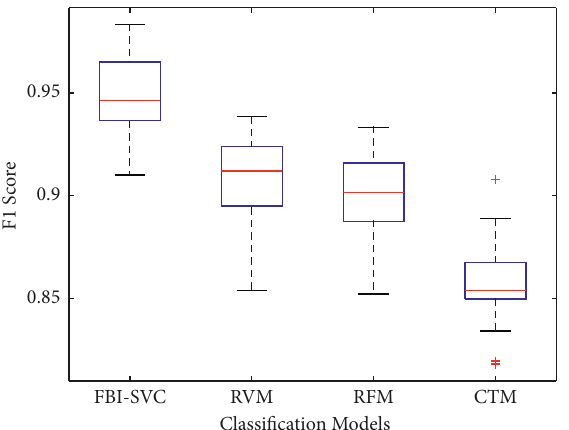
Figure 14: Box plot of F1 score values obtained from the employed machine learning models.